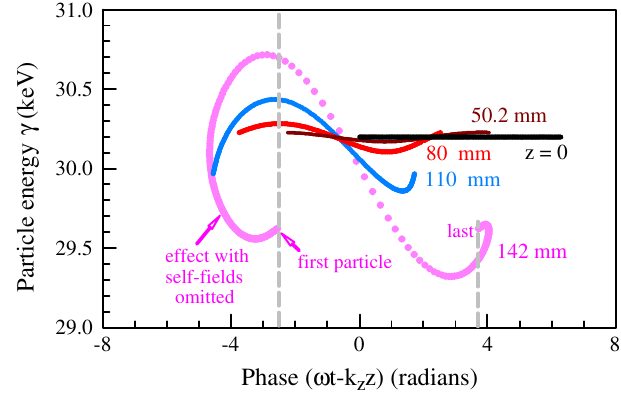
FIG. 6. (Color) Particle distributions on an energy-phase plane for axial distances z (cid:3) 0 (initial), 50.2 mm (linear growth regime), 80 mm, 110 mm, and 142 mm (saturation). Note: for the 142-mm distribution there are observable effects resulting from ignoring self-fields in simulations: the part on the left side of the long vertical dash line, and the part on the right side of the short vertical dash 58 : 3 = rad when the center drifts to 1.8 ( 0 : 57 (cid:3) ) at z (cid:3)